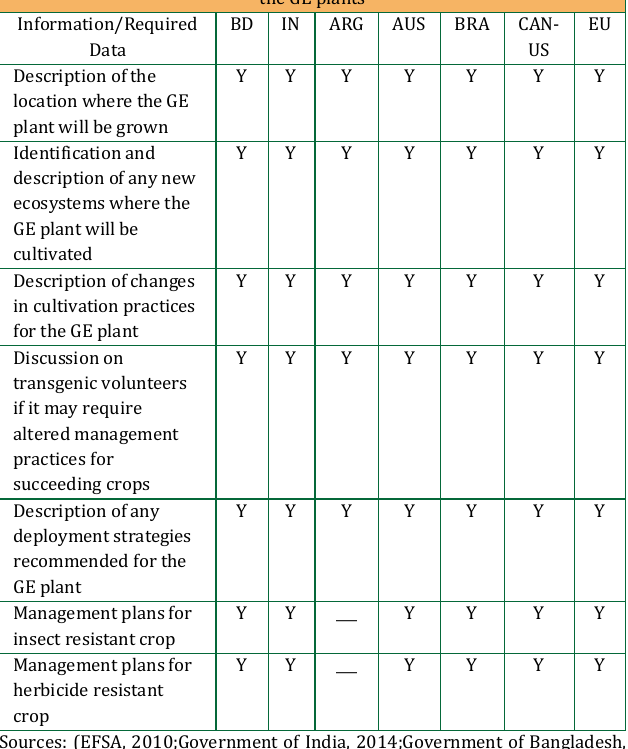
Table 5: Required data and information on the cultivation conventions of